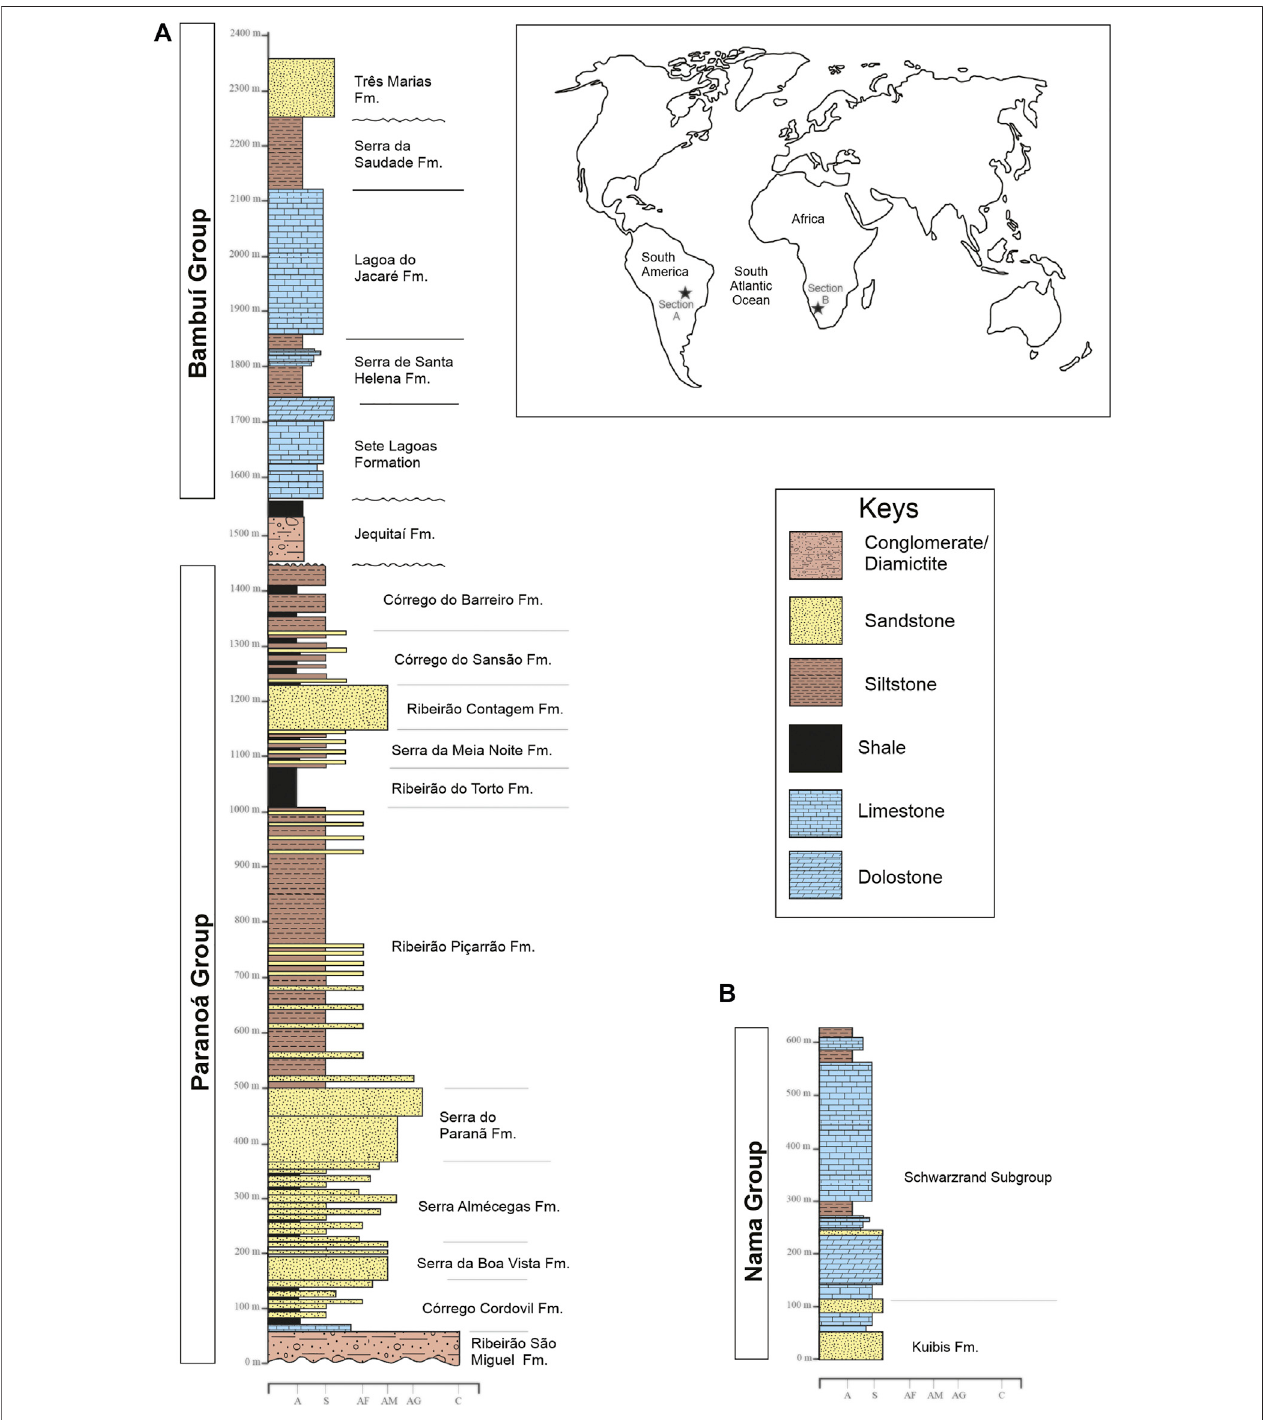
FIGURE 3 | (A) Regional stratigraphy of the Paranoá and Bambui groups, adapted from Campos et al. (2013); (B) Nama Group (after Gaucher et al., 2005).